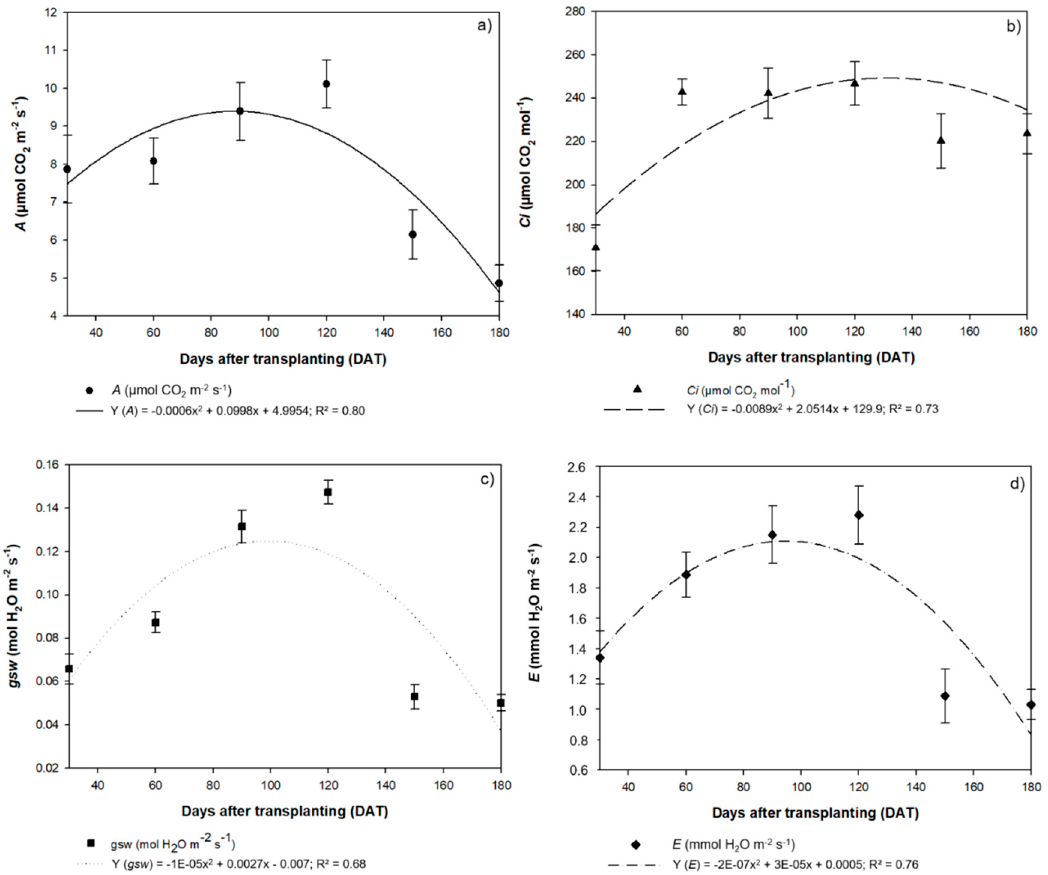
Figure 8. ( a ) Photosynthetic rate ( A ), ( b ) internal CO 2 concentration (Ci), ( c ) stomatal conductance ( gsw ), and ( d ) transpiration rate ( E ) recorded in the seedlings of Hymenaea courbaril L. cultivated in a hydroponic system and sampled at 30-day intervals across their initial development (30, 60, 90, 120, 150, and 180 days after transplantation). Marker bars = SE (observed for eight repetitions).